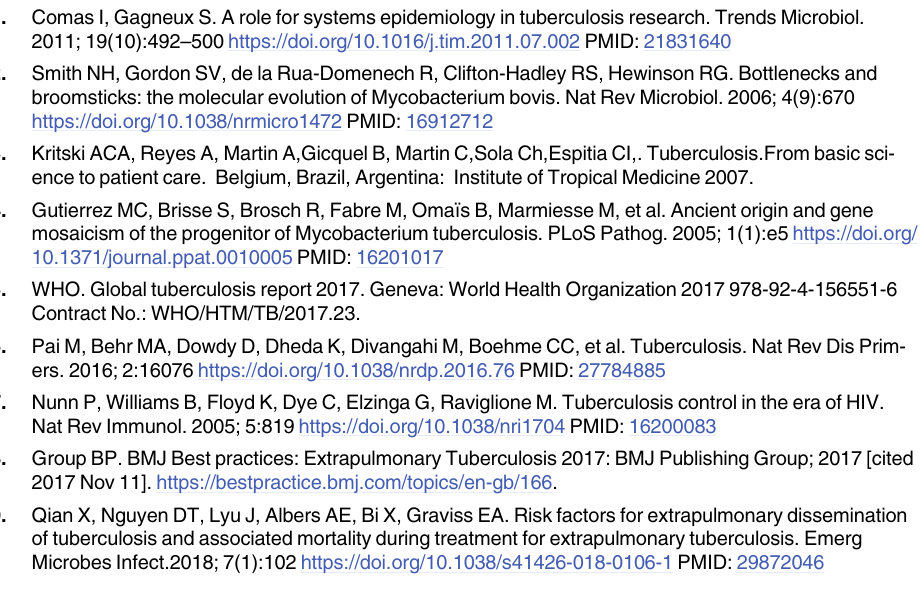
S1 Fig. Sensitivity analysis of gender, age and TBLN/HIV co-infection. S2 Fig. Funnel plots showing publication